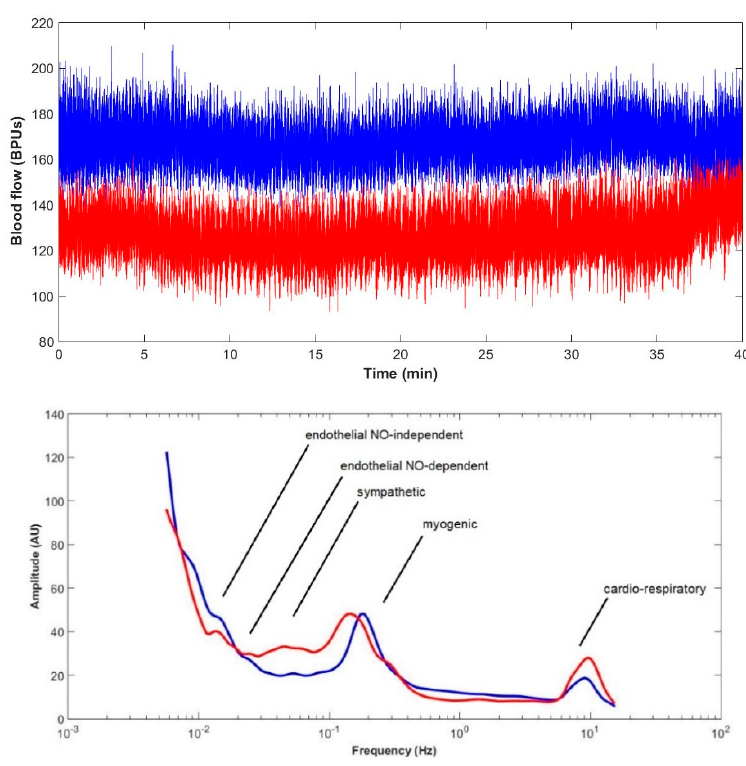
Figure 3. Baseline LDF signal registered in ta subset of the Control group animals for 40 min ( top ) and respective mean power spectrum obtained with the Wavelet analysis (WA) ( bottom ). Simultaneous recordings from both limbs (left, in red and right, in blue) are shown ( n =